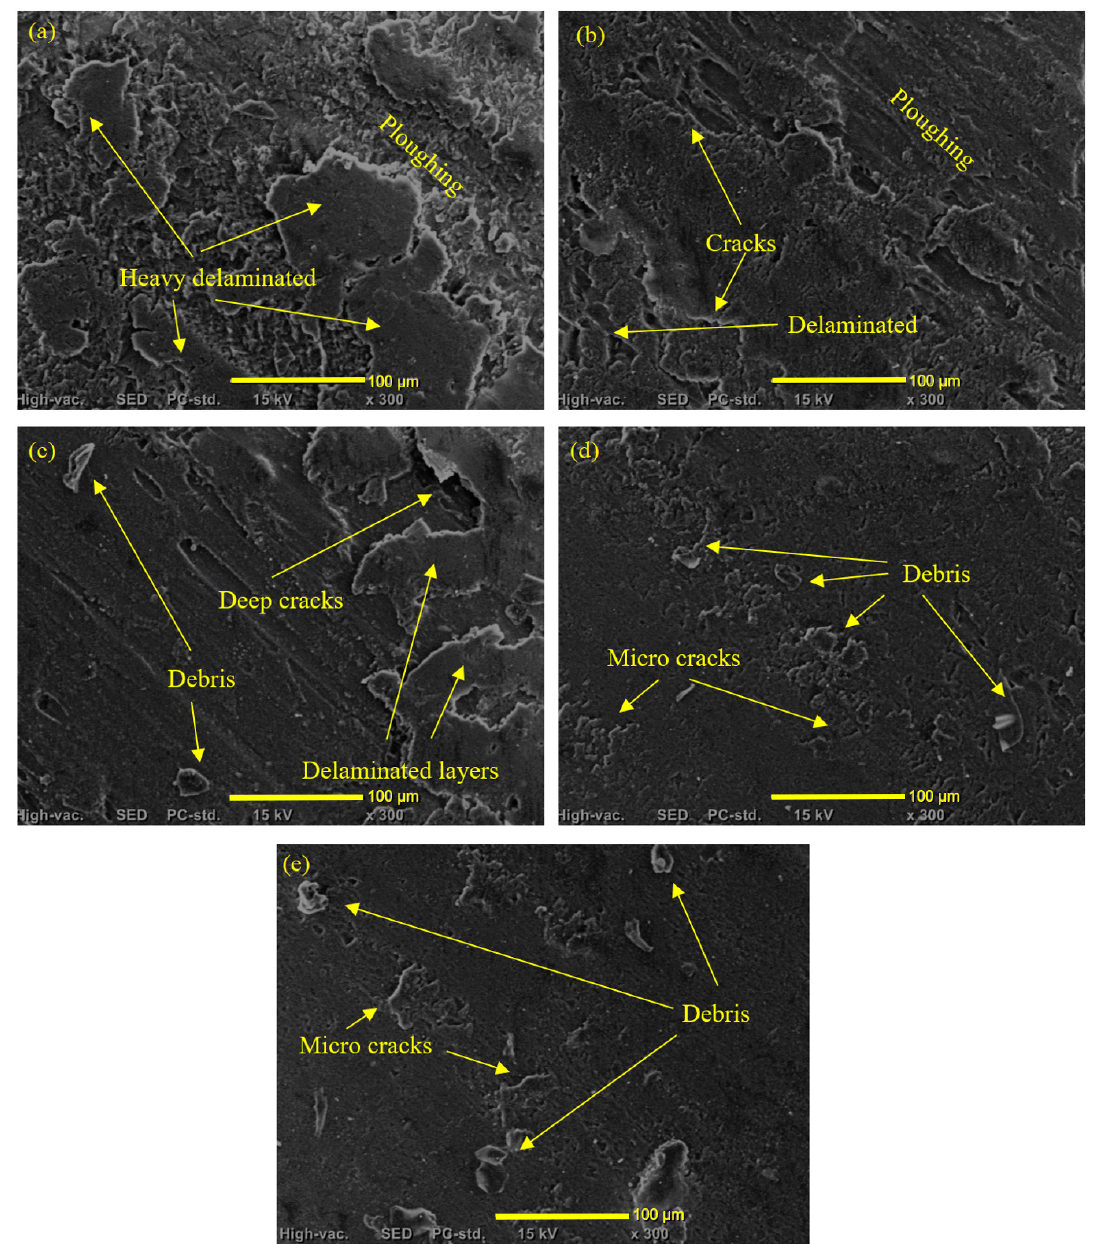
Figure 10. SEM of worn surfaces of ( a ) Mg ‐ TiO2 ‐ 0, ( b ) Mg ‐ TiO2 ‐ 1, ( c ) Mg ‐ TiO2 ‐ 3, ( d ) Mg ‐ TiO2 ‐ 5, and ( e ) Mg ‐ TiO2 ‐ 10.